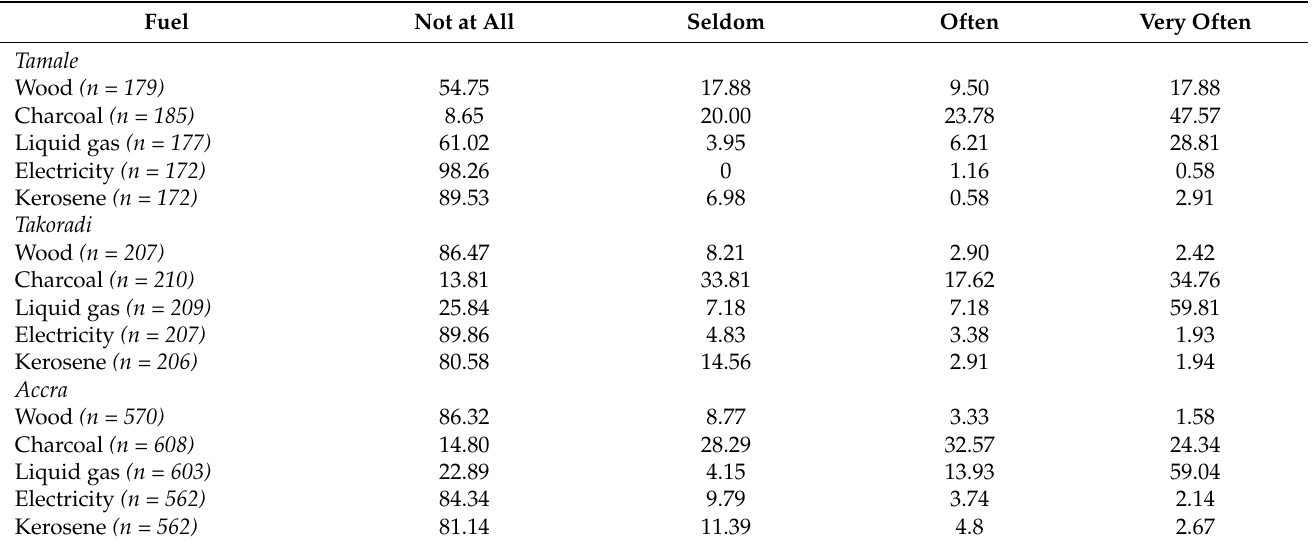
Table 2. The use of five fuels in cooking the main meal of the day by four frequency categories in urban households in Ghana,